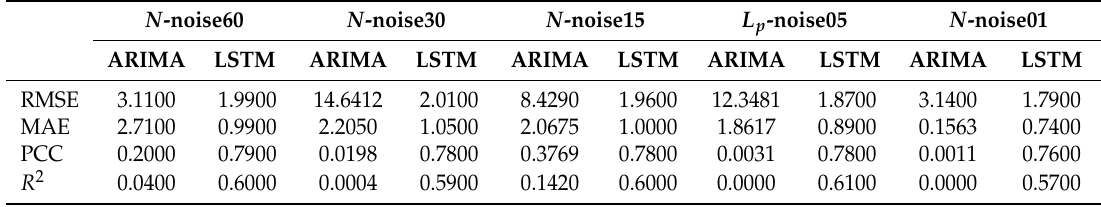
Table 4. Representation of RMSE, MAE, PCC and R 2 of the five data-sets of loudness values ( N ) for the LSTM proposed models and the ARIMA